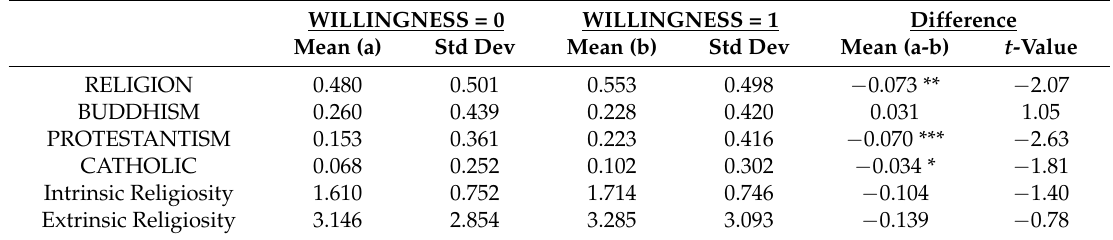
Table 4. Results of t -test by the willingness to donate organs